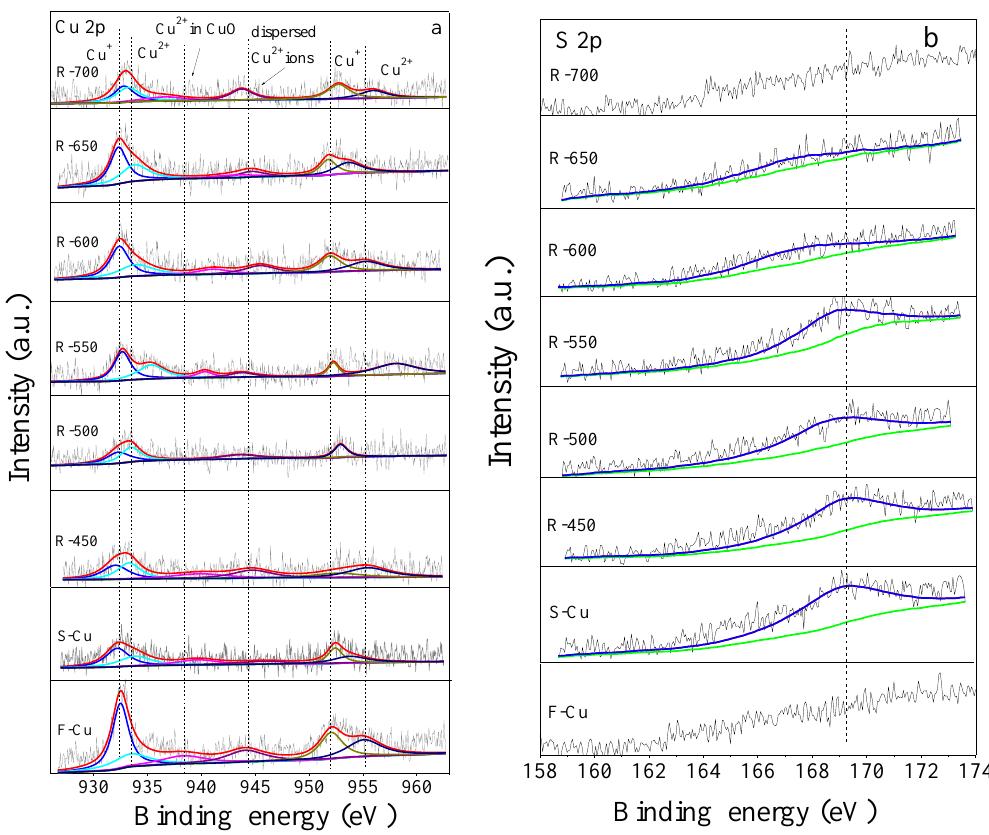
Figure 5. Cu 2p ( a ) and S 2p ( b ) X-ray photoelectron spectra (XPS) spectra of Cu-SSZ-13 catalysts in Figure 5 . Cu 2p (a) and S 2p (b) X-ray photoelectron spectra (XPS) spectra of Cu-SSZ-13 catalysts fresh, sulfated and regenerated in fresh, sulfated and regenerated state. Table 2. The atomic ratio of surface Cu and integral areas of Cu 2p and S 2p determined from XPS spectra over Cu-SSZ-13 catalysts in fresh, sulfated and regenerated states . Samples